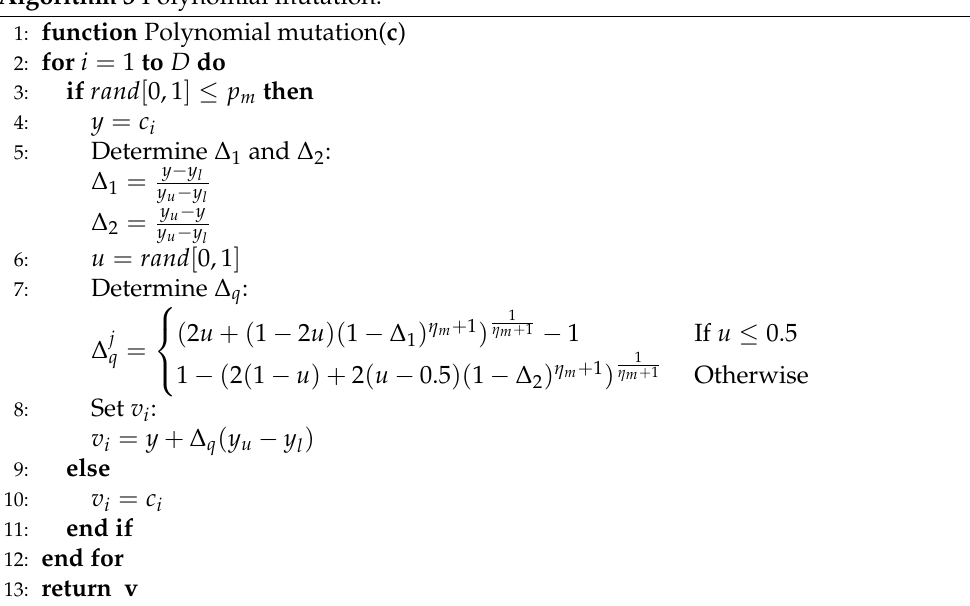
Algorithm 3 Polynomial mutation.